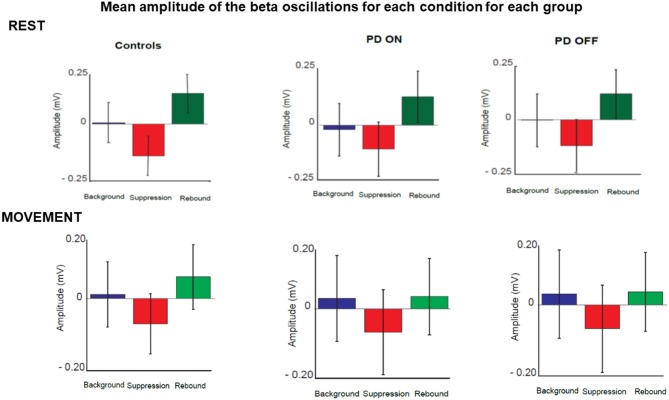
Mean amplitude of beta oscillations for each condition and each group in three selected time windows. These corresponded to the three phases of beta oscillations modulation calculated as background (between 180 and 625 ms before the stimulus), suppression (between 165 and 378 ms after stimulus) and rebound (between 535 and 980 ms).